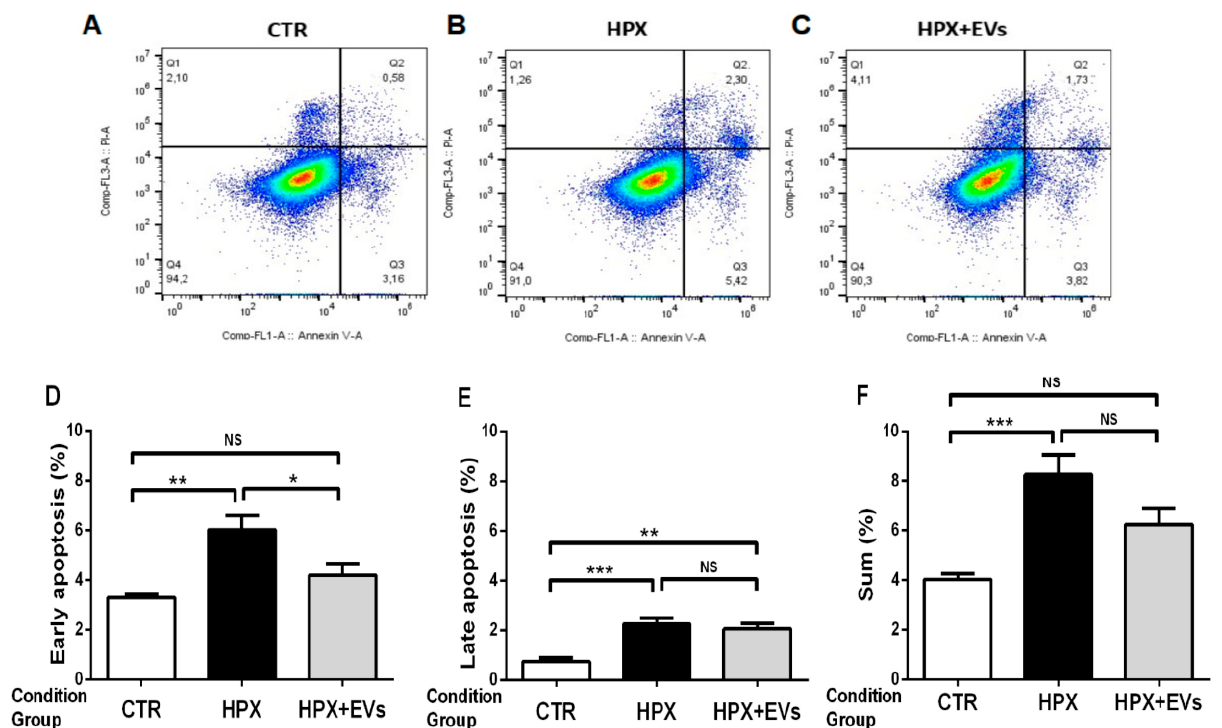
Figure 8. Co-culture with EVs decreases apoptosis of a lineage of proximal tubule cells (HK-2 line) subjected to hypoxia. Representative cytometry analysis of 3 × 10 5 HK-2 cells cultivated in 1.5 mL of DMEM without serum for 24 h. ( A ) Cultures in normoxia (CTR). ( B ) Hypoxia (1% O 2 ) (HPX) in the absence of EVs. ( C ) HPX in the presence of 2 × 10 9 EVs (HPX+EVs). Then the cells were incubated for 24 h under 21% O 2 in the same medium. ( D – F ) Quantification of cell death is expressed as a percent of total cells. ( D ) Early apoptosis, corresponding to ANX + PI − cells. ( E ) Late apoptosis, corresponding to ANX + PI + cells. ( F ) Sum of the cells that suffered early and late death: ANX + PI − cells + ANX + PI + cells. Bars represent mean ± SEM of different cultures in the conditions CTR ( n = 16), HPX ( n = 14), and HPX+EVs ( n = 9). * p < 0.05; ** p < 0.01; *** p < 0.001; NS: not significant (one-way ANOVA followed by Tukey´s test).